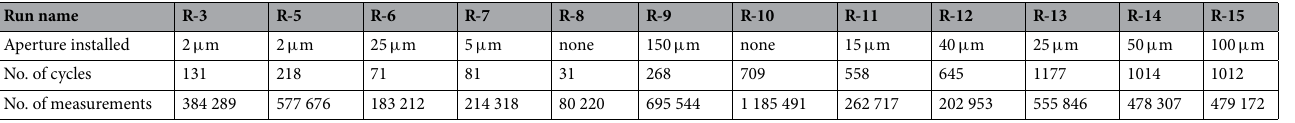
Table 2. Basic statistics of the experiment